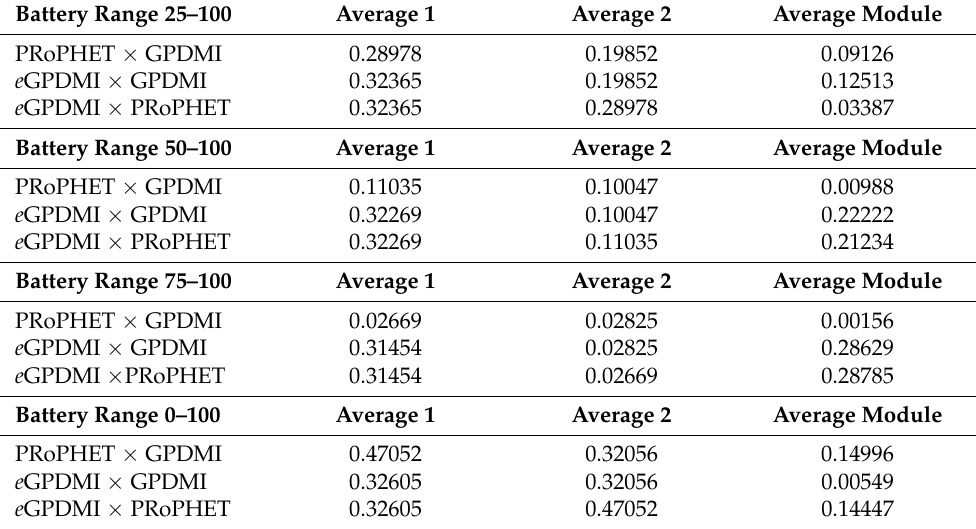
Table 11. Tukey test applied to the ANOVA result obtained in Table